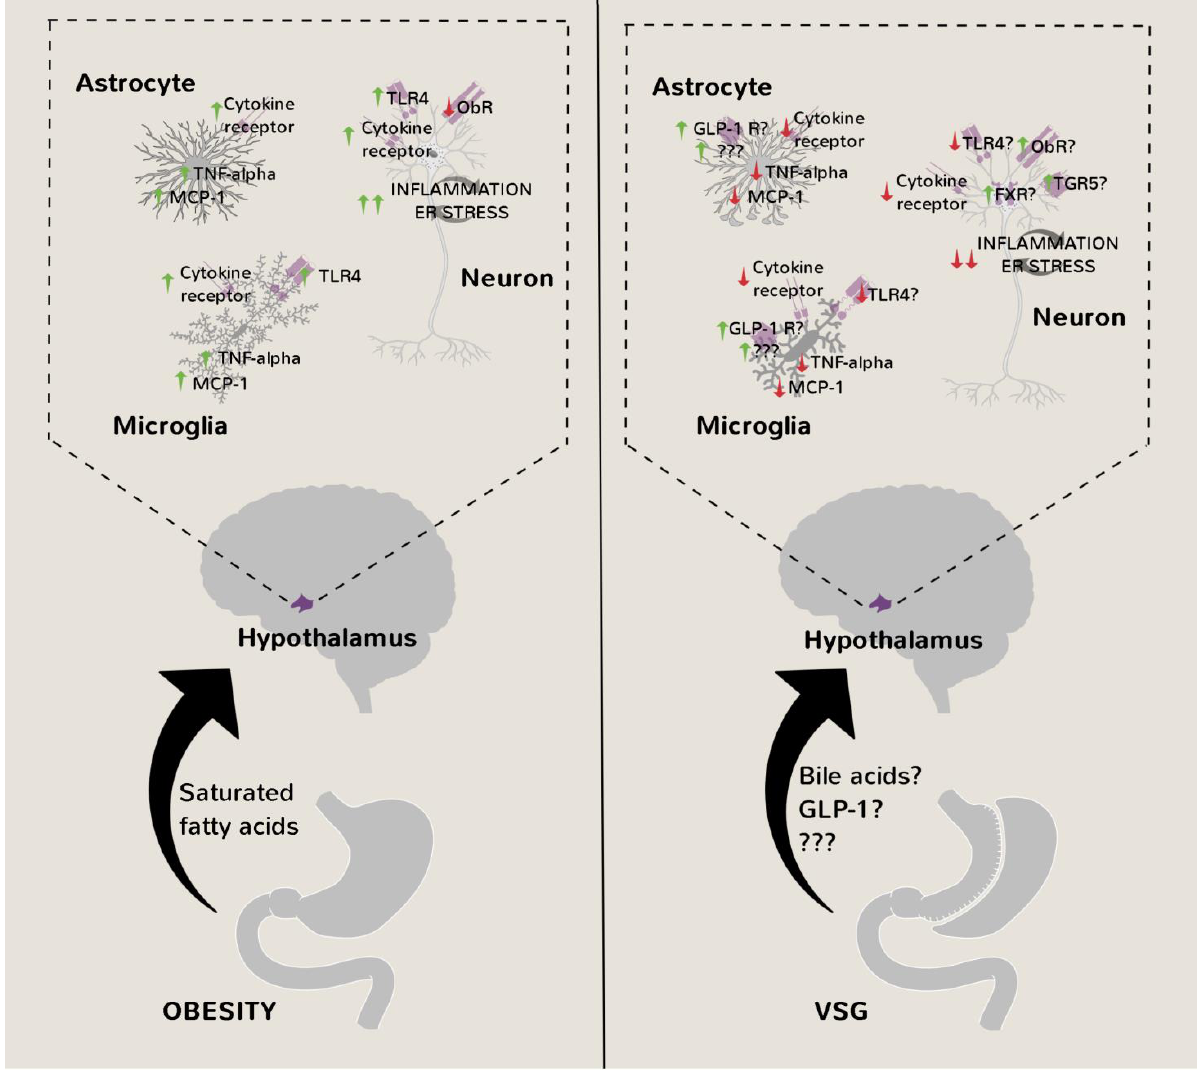
FIGURE 4: Amelioration of hypothalamic inflammation, ER stress and gliosis after VSG. After VSG, activation of FXR/TGR5 in hypothalam- ic neurons from the rise in circulating bile acids, and GLP-1 receptors in hypothalamic glial cells from the rise in circulating GLP-1, may contribute to amelioration of inflammatory processes, ER stress, gliosis and leptin resistance in obesity, thereby potentially contributing to reduced food intake and lasting weight loss. FXR - farnesoid X receptor, GLP-1 - glucagon-like peptide 1, ObR – leptin receptor, MCP-1 - monocyte chemoattractant protein 1, TGR5 - Takeda G-protein 5 receptor, TLR4 – toll-like receptor 4, TNF-alpha – tumor necrosis factor alpha, VSG - vertical sleeve